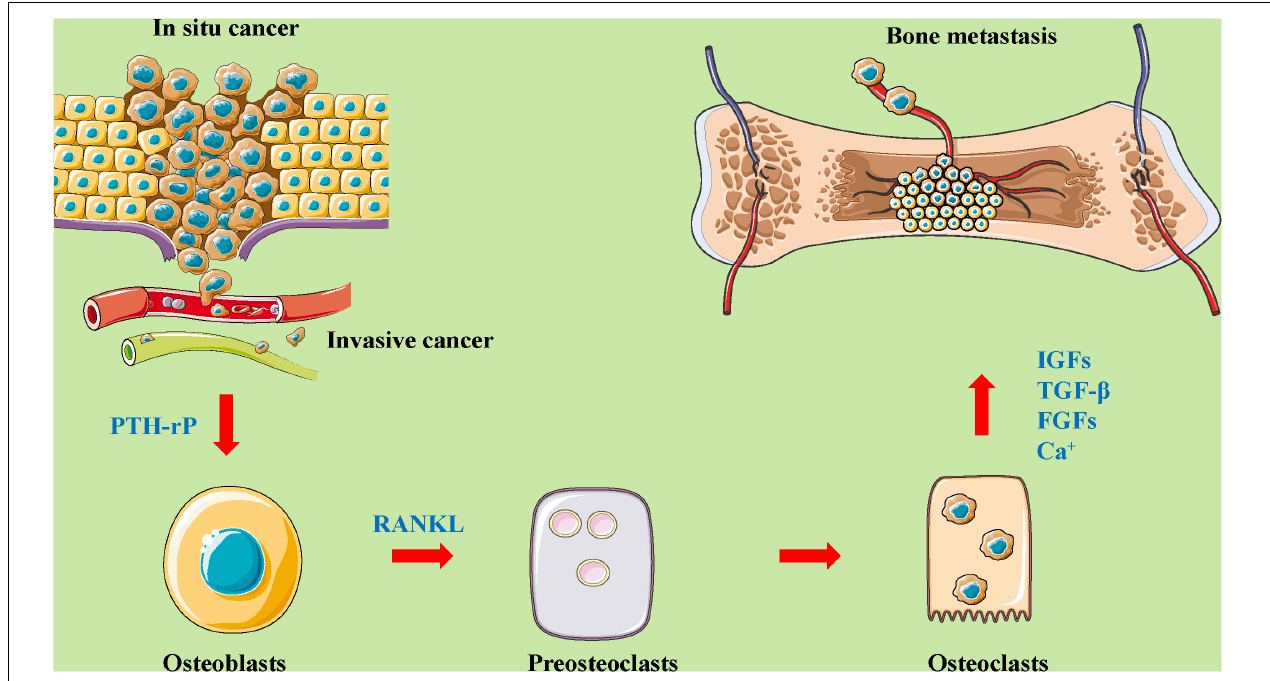
FIGURE 2 | The roles and mechanisms of the bone microenvironment in tumor metastasis to bone. A complex and abnormal cycle of bone metastasis involving mutual interactions between tumor cells, bone cells (osteoclasts and osteoblasts), and the bone matrix. As shown in this figure, in situ cancer cells enter the blood vessels, causing proliferation, migration, and invasion. Then, these cells act on osteoblasts by regulating PTH-rP, which affects preosteoclasts and osteoclasts through the mediation of a related protein (such as RANKL). Osteoblasts and osteoclasts affect bone metastases by mediating the expression and secretion of factors (for example, IGFs, TGF- β , FGFs, CA 2 + ). FGFs, fibroblast growth factors; IGFs, insulin-like growth factors; PTH-rP, parathyroid hormone-related protein; RANKL, receptor activator for nuclear factor- κ B ligand; TGF- β , transforming growth factor- β